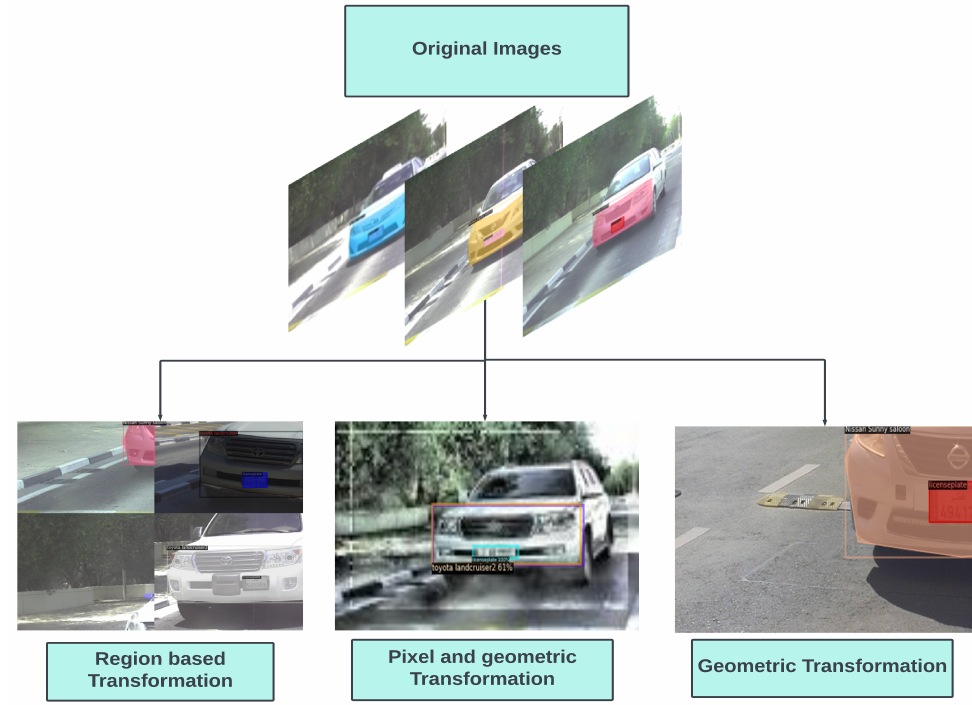
Figure 4. Augmentation